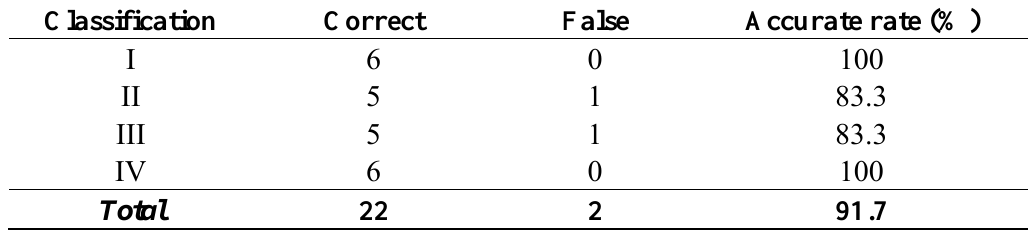
Table 3. The analysis results of pork in field measurement (Sample Number =